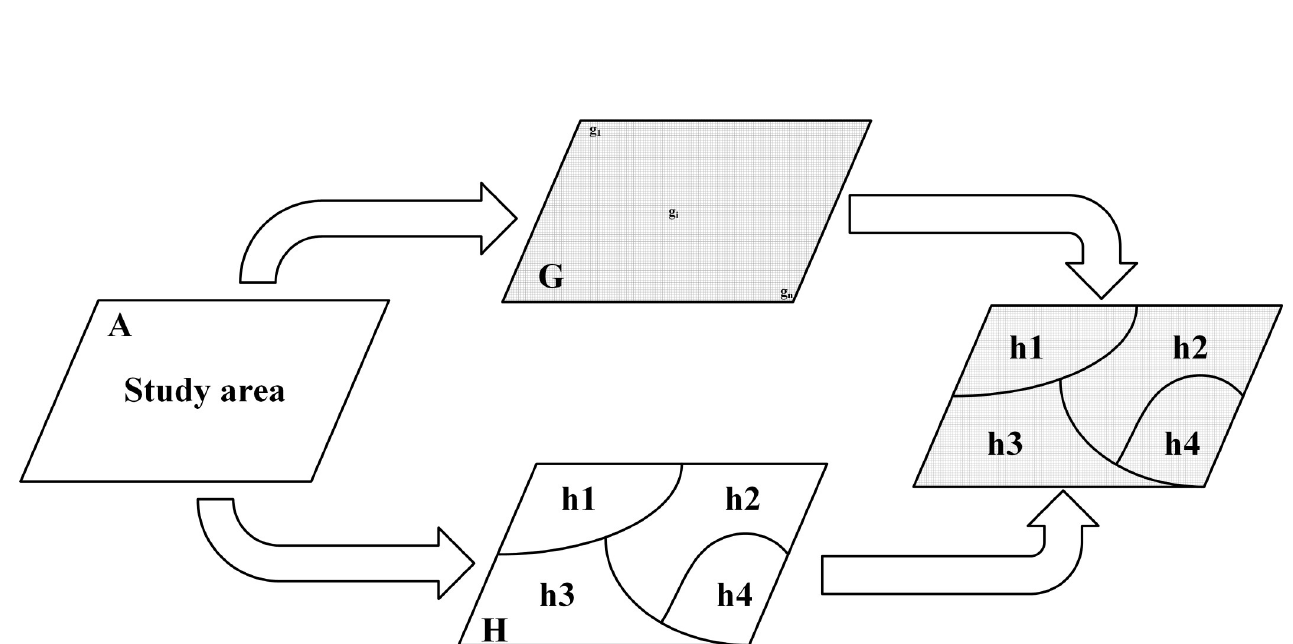
Fig 4. Schematic diagram of the geographical detector. A Study region, G grid system, H geographical stratum.